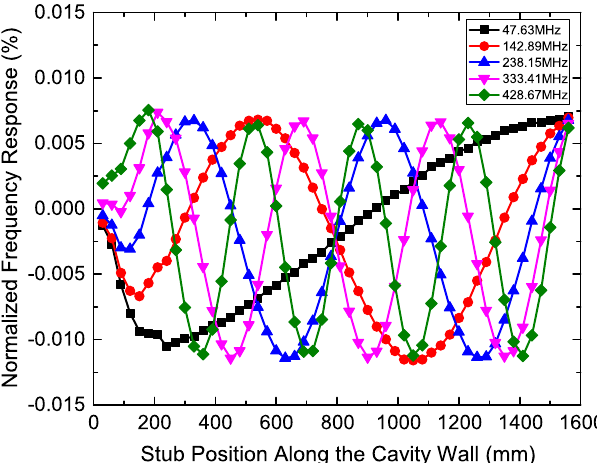
FIG. 8. Tuner position simulation for the 5 harmonics modes cavity with a cylinder trail stub radius R ¼ 20 mm, insertion height H ¼ 10 mm, perturbation moving along the outer con- ductor wall in the axial direction.